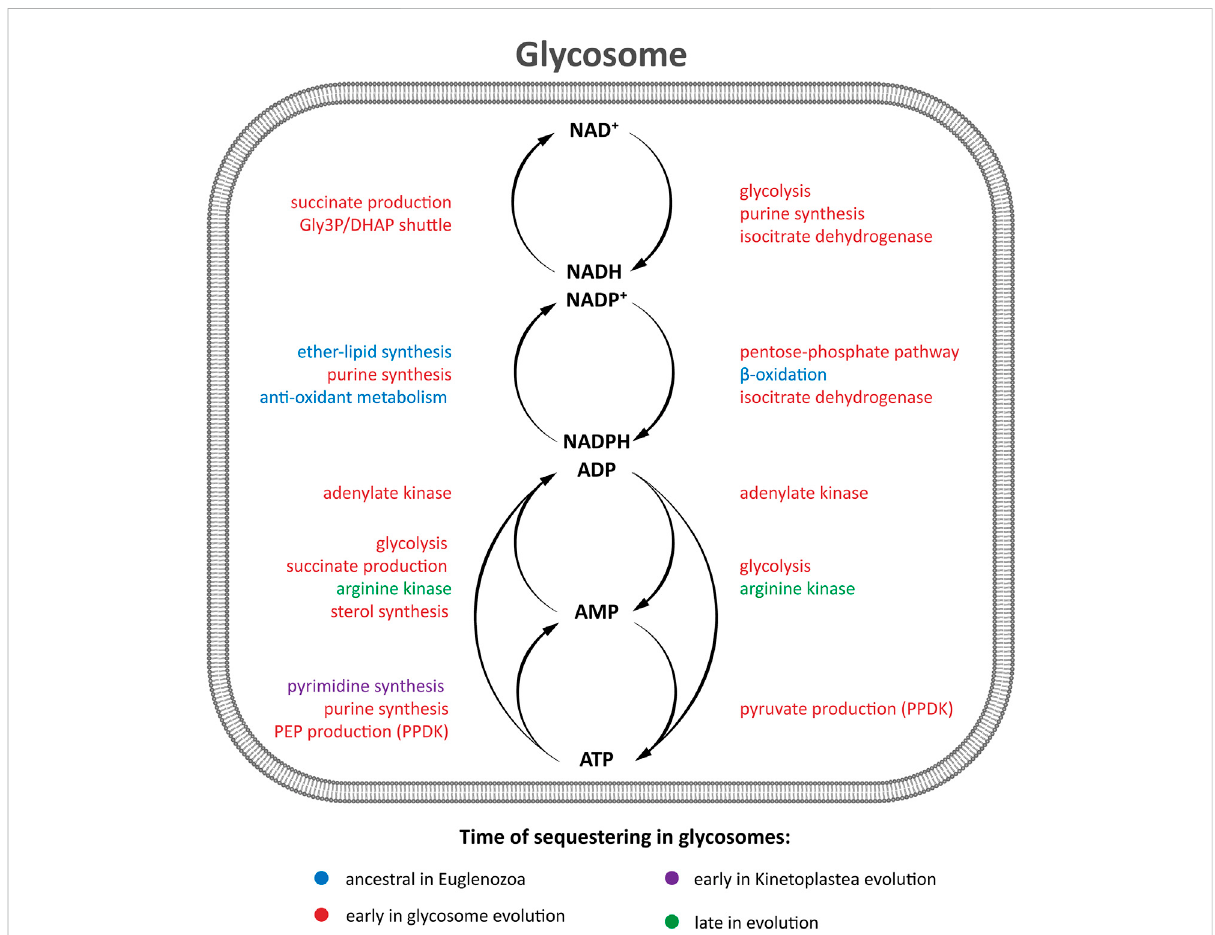
FIGURE 8 Glycosomal homeostasis of cofactors. Glycosomes harbour a pool of adenine nucleotides and nicotinamide-adenine nucleotides, separate from the cytosolic pool, that is involved in various branches of glycosomal catabolism and anabolism. The presence or absence of PTS motifs suggests that enzymes of the metabolic processes listed in the fi gure were sequestered at different stages in the evolution of glycosomes: already present inperoxisomes ofancestral organisms (blue);sequesteredwithinglycosomesduringorshortlyafter theorigin ofthese organelles from peroxisomes (red); sequestered only in kinetoplastids at an early stage (mauve); sequestered late in glycosomes of some taxa (green). However, it should be noted that speci fi c enzymes of some processes mentioned in the fi gure were not compartmentalised or even lost from all or certain taxa, as described in the